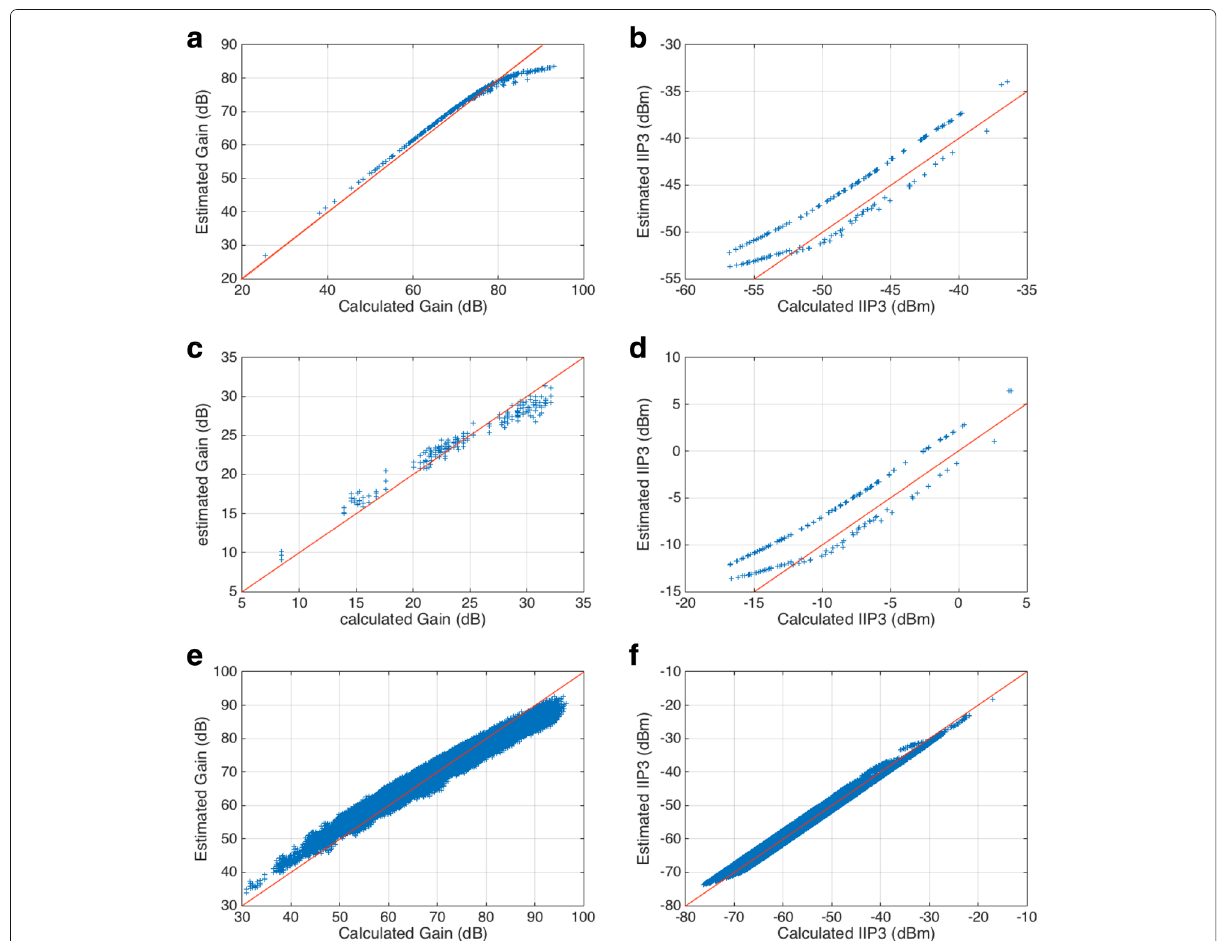
Fig. 7 Simulation results for RF impairment estimation using the design of experiments (DoE) method. a Estimated gain ˆ Y of configurations in a sample configuration set. b Estimated IIP 3 ˆ Y of configurations in a sample configuration set. c Estimated gain ˆ θ of each amplifier. d Estimated IIP 3 ˆ